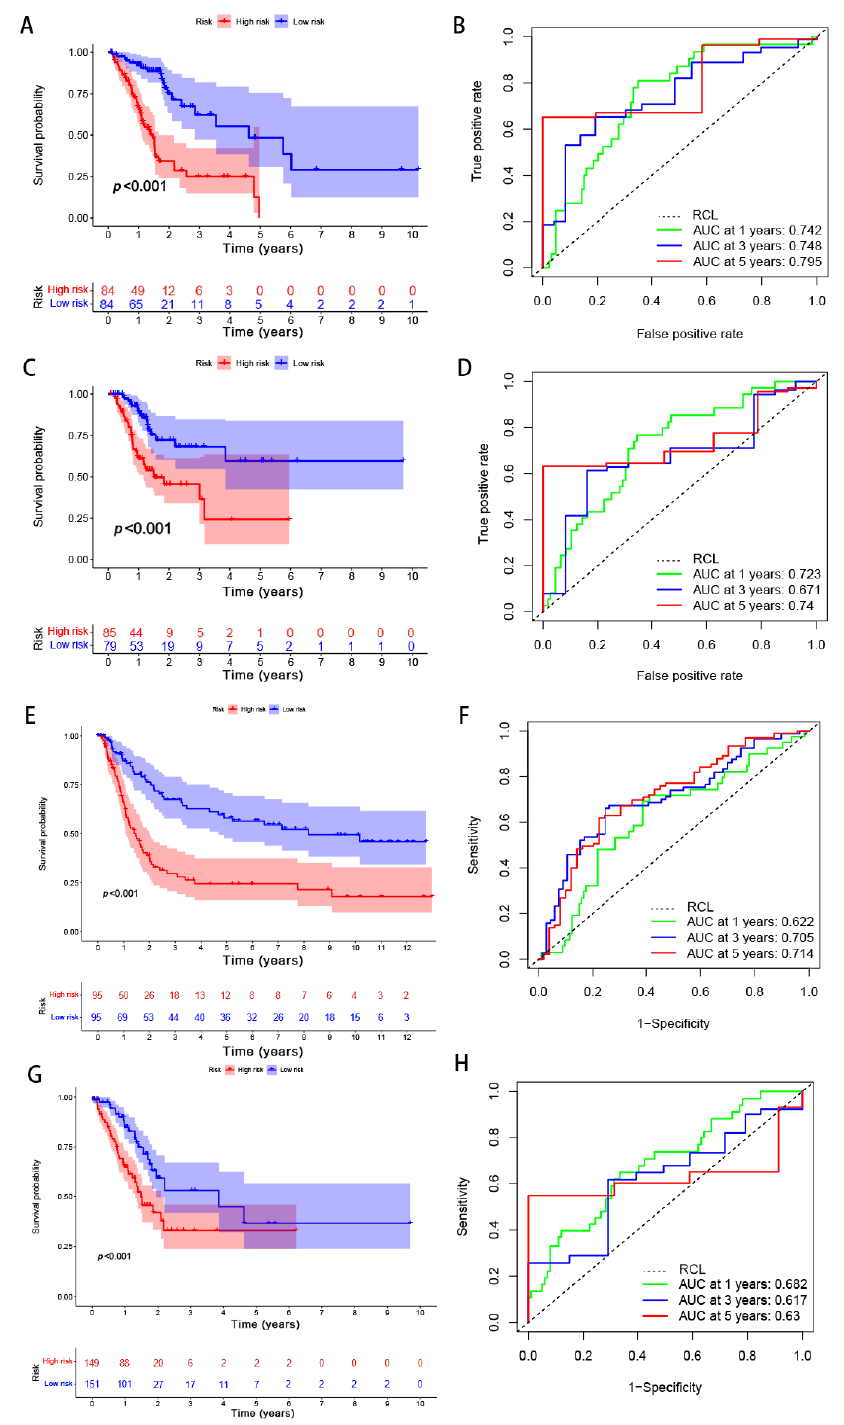
Figure 8. Internal and external validation of the performance regarding the predicted signatures. ( A ) The Kaplan–Meier survival curves of the training set. ( B ) The ROC curves and AUCs for the one-, three-, and five-year survival groups of the training set. ( C ) The Kaplan–Meier survival curve of the testing set. ( D ) The ROC curve and AUCs for the one-, three-, and five-year survival groups of the testing set. ( E ) The Kaplan–Meier survival curves of the GSE15459 set. ( F ) The ROC curves and AUCs for the one-, three-, and five-year survival groups of the GSE15459 set. ( G ) The Kaplan–Meier survival curves of the GSE62254 set. ( H ) The ROC curves and AUCs for the one-, three-, and five-year survival groups of the GSE62254 set. RCL: random guessing line, the baseline of a ROC